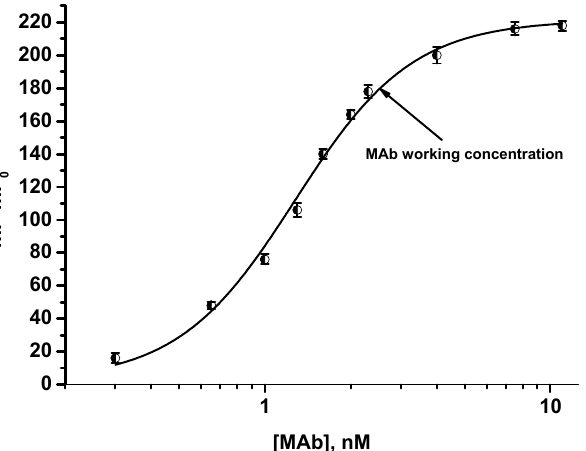
Figure 4. Dependence of changing the fluorescence polarization signal (mP-mP 0 ) on the concentration of MAbs after the interaction with tracer (2.5 nM), n = 3.